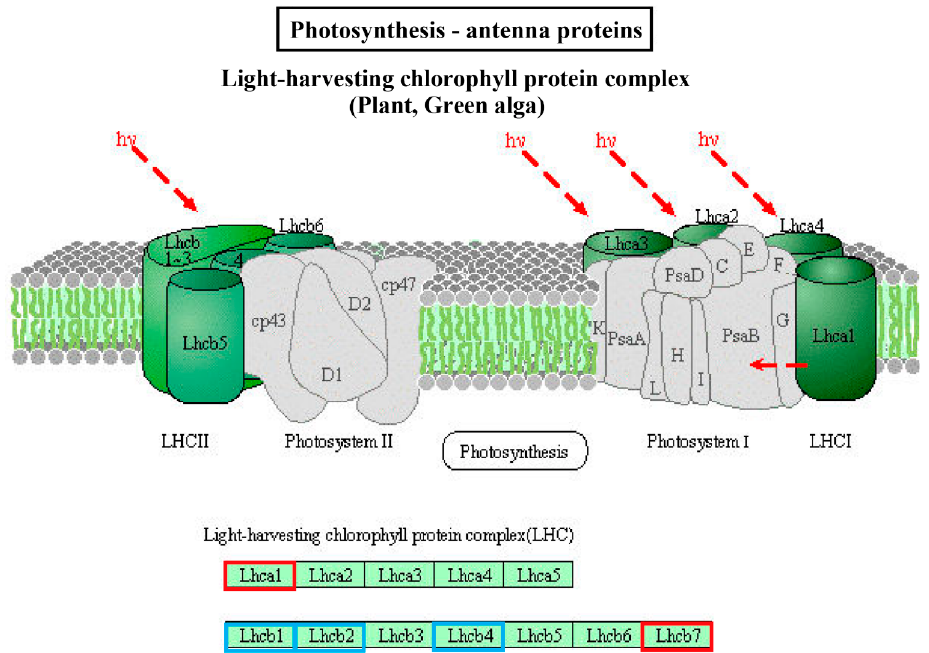
Figure 7. The “photosynthesis—antenna proteins” enriched by KEGG analysis of DE mRNA corresponding genes in the cultivar “Huoche” under heat stress. KO nodes containing up-regulated genes are marked with red boxes, while KO nodes containing down-regulated genes are marked with blue boxes. Lhca1, light-harvesting complex I chlorophyll a/b binding protein 1; Lhcb1, light-harvesting complex II chlorophyll a/b binding protein 1; Lhcb2, light-harvesting complex II chlorophyll a/b binding protein 2; Lhcb4, light-harvesting complex II chlorophyll a/b binding protein 4; Lhcb7, light-harvesting complex II chlorophyll a / b binding protein 7.